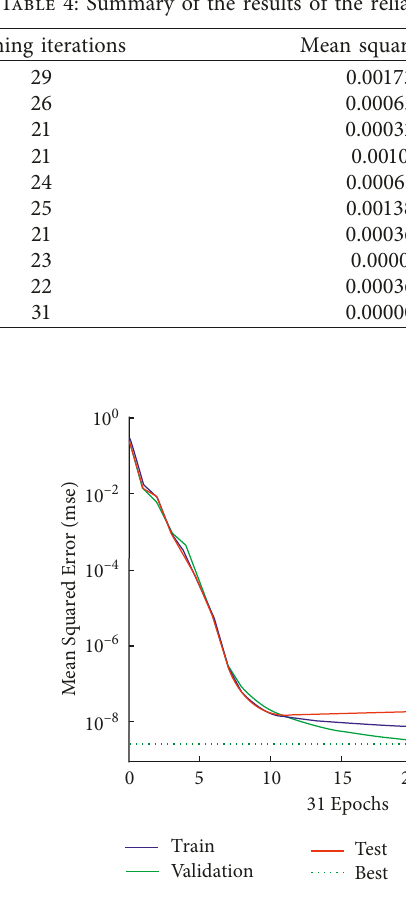
Figure 6: Training curve of RBF neural network.